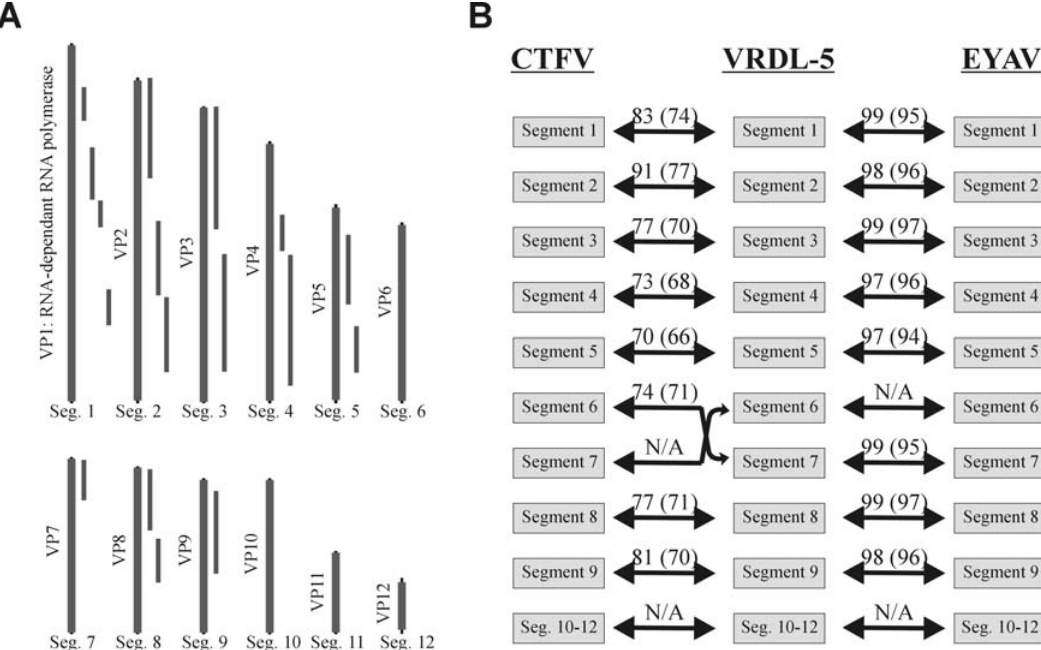
Figure 3. Eyach Virus. ( A ) Positions of VRDL4 fragments amplified relative to segmented Coltivirus genome. ( B ) Pairwise amino acid (nucleotide) percent identities between VRDL4 and CTFV and VRDL4 and EYAV for each segment.